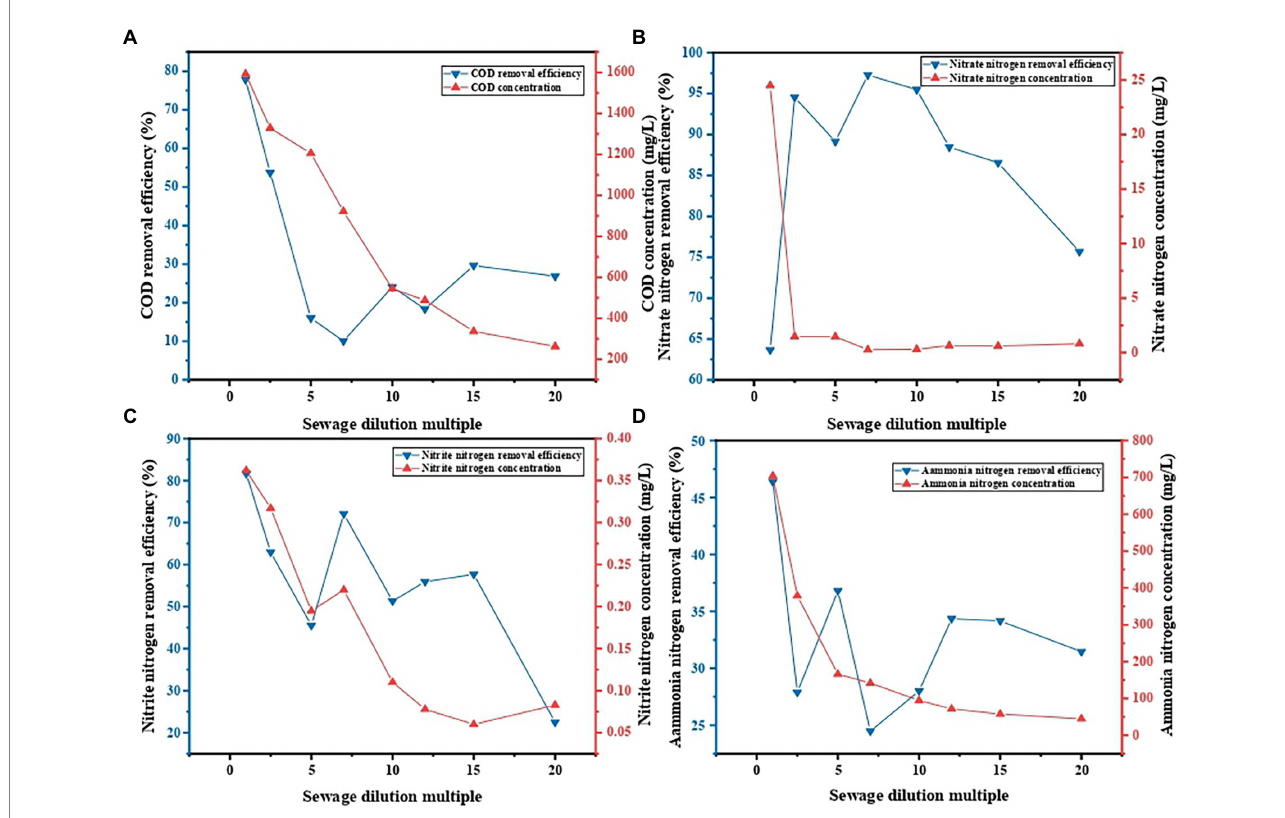
FIGURE 6 Contaminant removal under different wastewater concentrations: (A) COD removal, (B) NO 3 − -N removal, (C) NO 2 − -N removal, and (D) NH 4+ -N